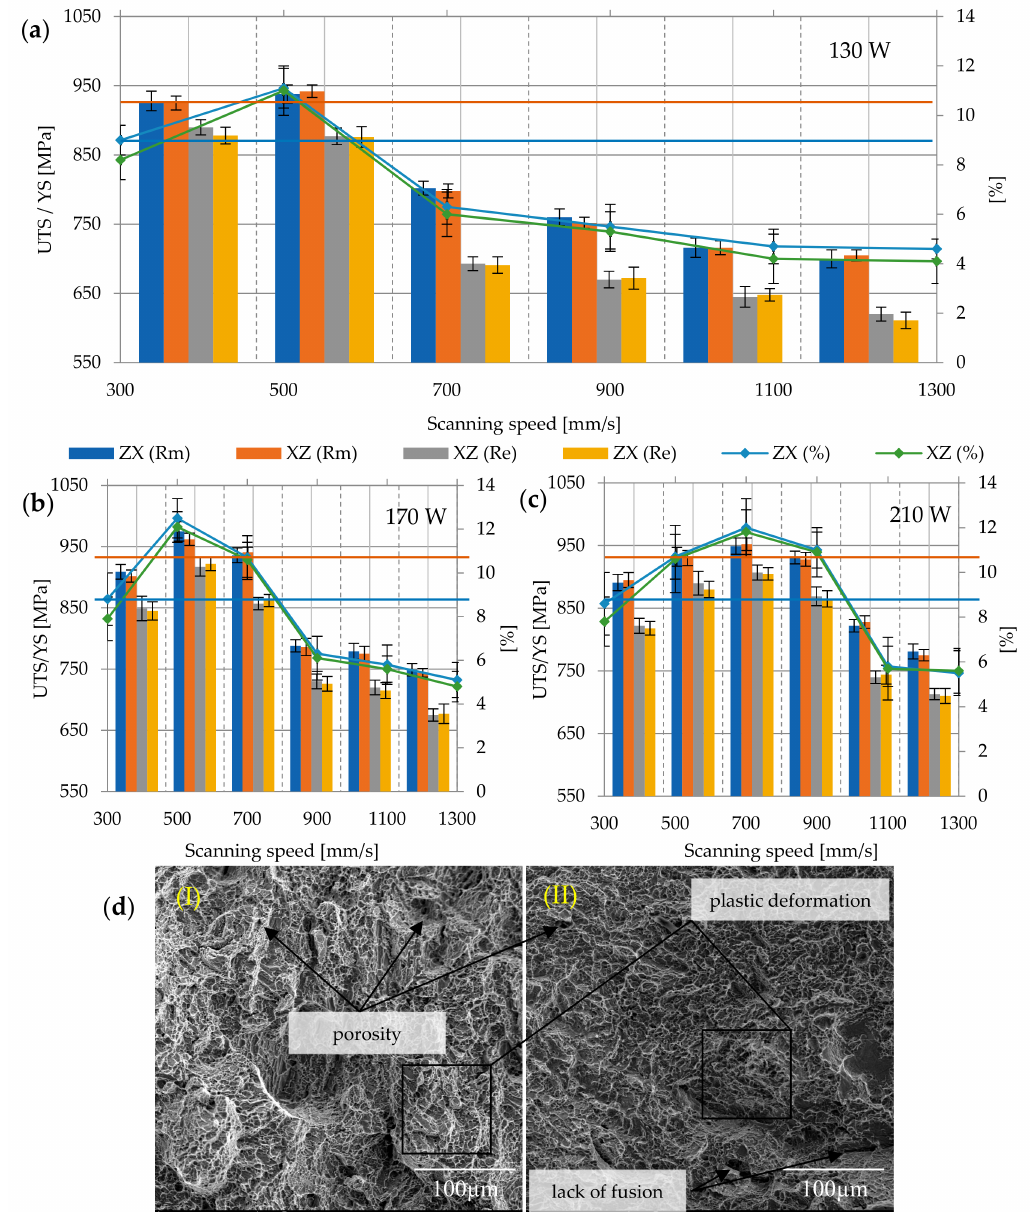
Figure 10. Strength parameters of samples heat treated at 650 ◦ C with di ff erent laser speeds and powers: ( a ) 130W, ( b ) 170W, ( c ) 210W, and ( d ) fracture surface: (I) 130 W, 300 mm / s, ZX; (II) 130 W, 300 mm / s, XZ; 900 × ; Rm min and Re min for Ti6Al4V in accordance with ASTM F